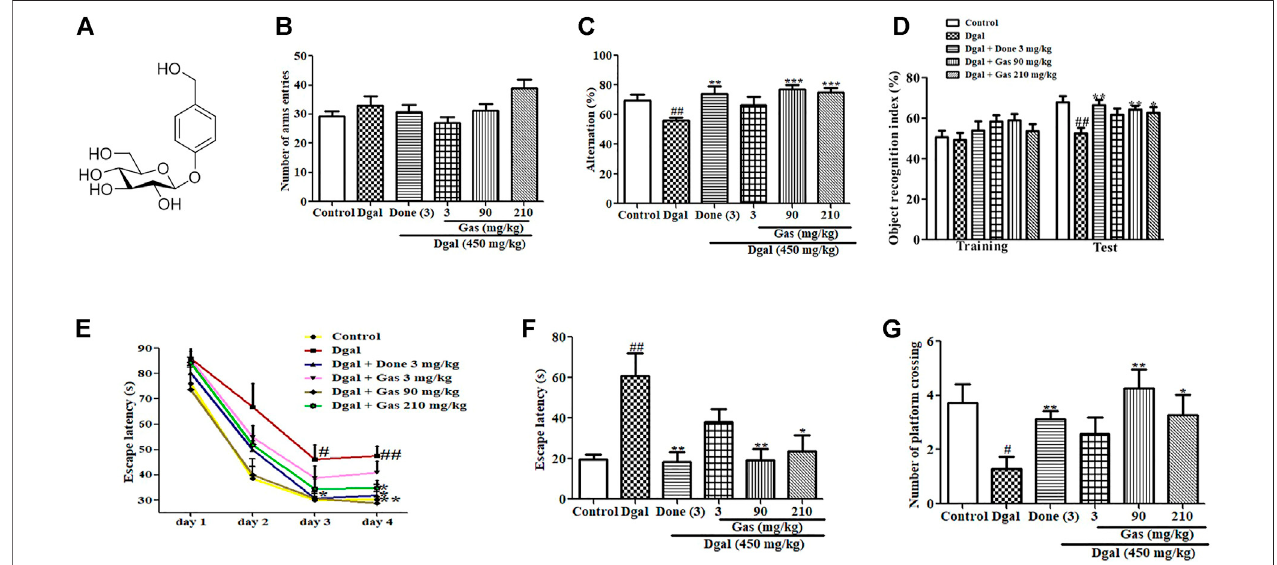
FIGURE1| Chemical structure ofGasand changes in learning memoryand spatialmemory ofADmiceafteradministeringGas. (A) ChemicalstructureofGas. (B) Changes in the number of arm entries in the Y-maze test. (C) Alternation in the Y-maze test. (D) Object recognition index in the NOR experiment. (E) Escape latency in the training phase in the water maze test. (F,G) Escape latency and number of platform crossings in the water maze test. The number of animals in each group is eight, and thedataare presented asmeans ±SEM. #and## indicatesigni fi cantdifferences at p < 0.05 and p < 0.01 compared with those of thenormal control, respectively; *, **,and *** indicate signi fi cant differences at p < 0.05, p < 0.01, and p < 0.01 compared with those of the Dgal group, respectively.